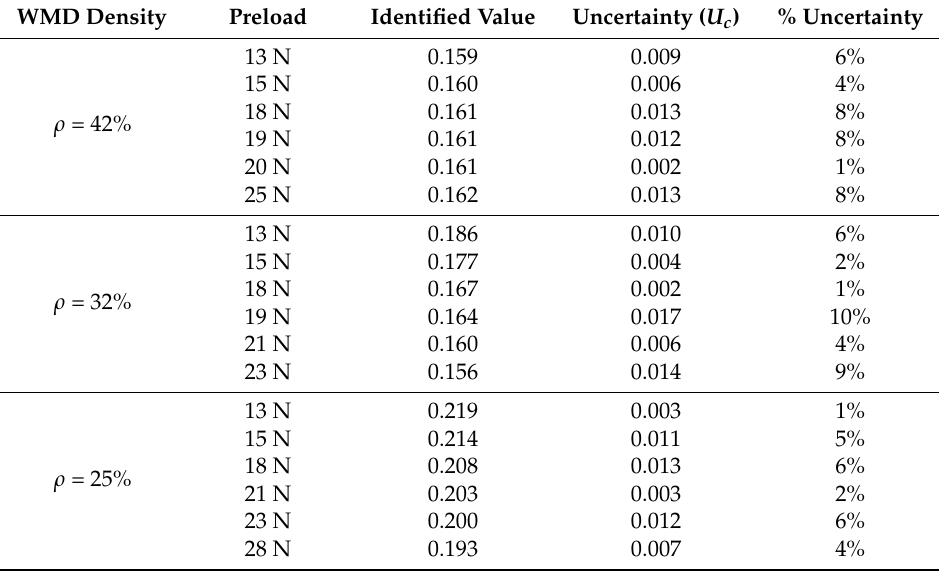
Table A4. Combined standard uncertainty of WMD dry-friction coefficients ( µ f ) in Figure